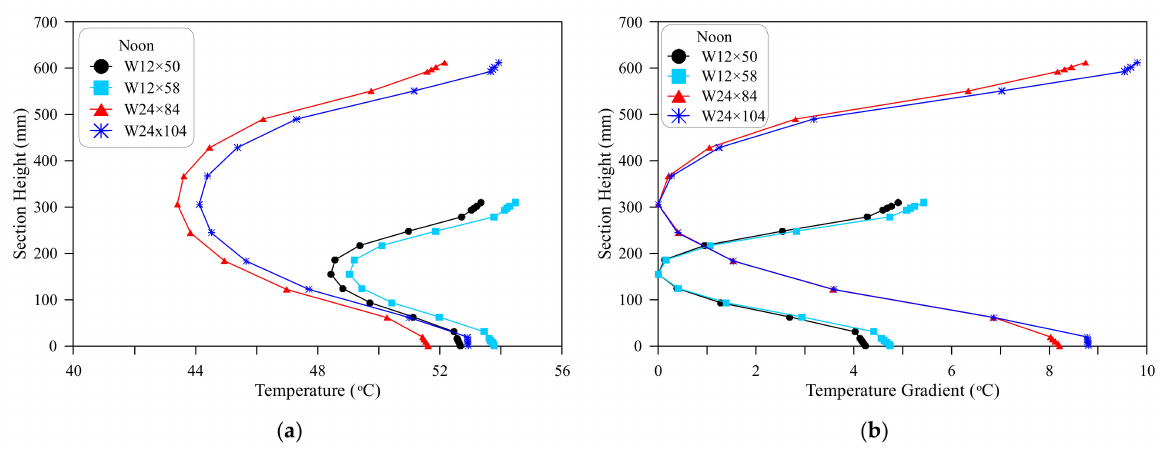
Figure 14. Vertical temperature distributions and temperature gradients at noon: ( a ) Temperature distributions; ( b ) Temperature gradients.